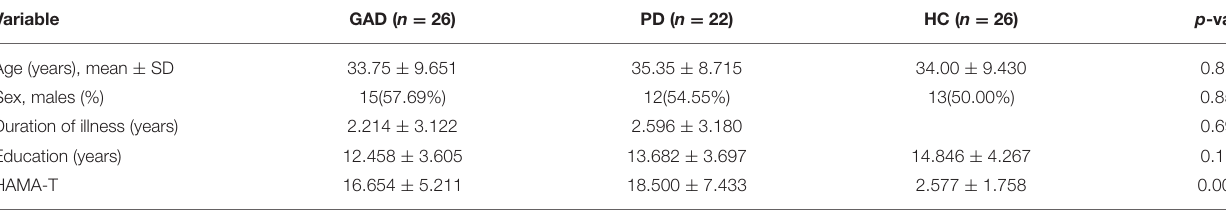
TABLE 1 | Demographic and clinical characteristics of patients with GAD, patients with PD, and HCs in this study.